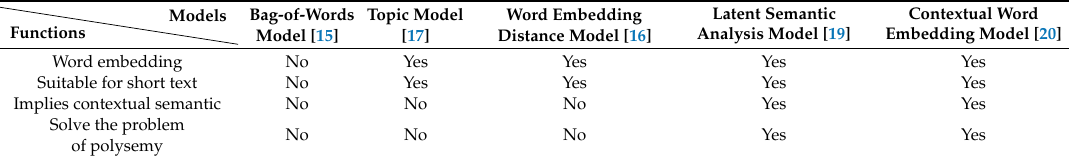
Table 1. Comparison of characteristics of the language embedding